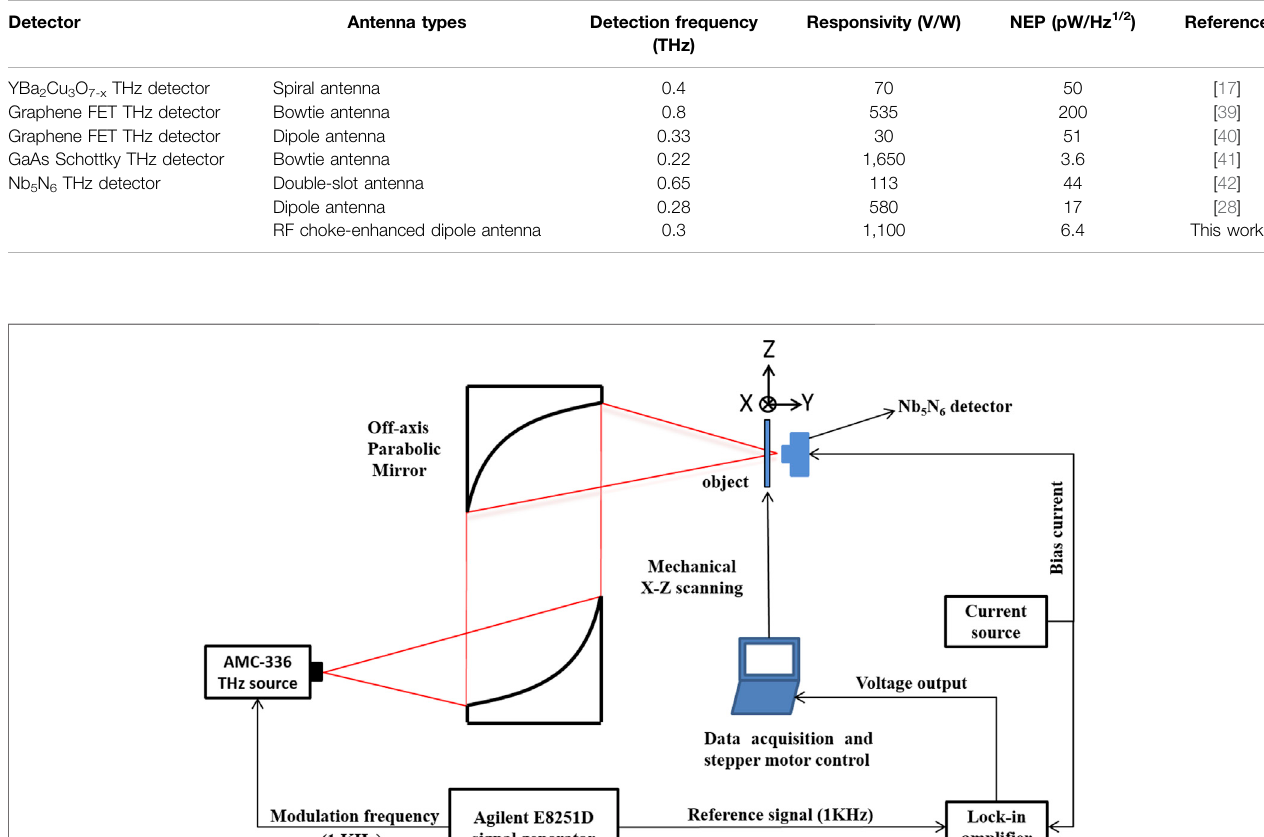
Frontiers in Physics |